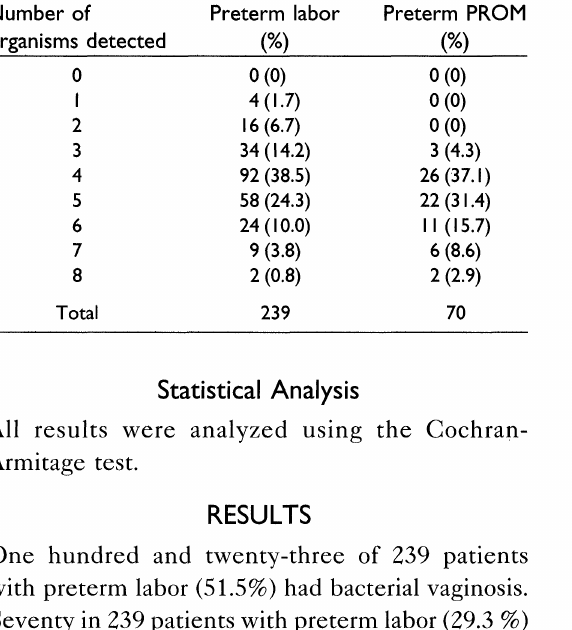
TABLE 2. The number of different species detected in all patients with preterm labor and bacterial vaginosis (BV) and those with preterm PROM Number of Preterm labor